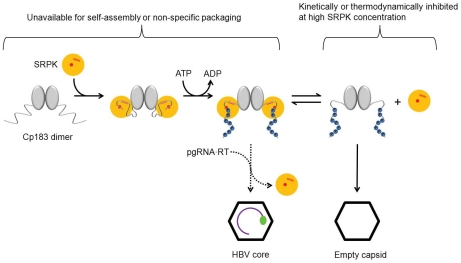
Scheme describing SRPK-gated mechanism of HBV core and capsid assembly.Binding of SRPK to unphosphorylated Cp183 prevents self-assembly and packaging nucleic acid. Subsequent phosphorylation weakens SRPK association to slowly release free Cp183 to form capsid. Even modest concentrations of free SRPK should suppress the concentration of free Cp183 and therefore prevent capsid assembly. In vivo, a likely catalyst of Cp183 release is reverse transcriptase-bound pgRNA that can displace weakly bound SRPK and induces assembly resulting in packaging specificity.